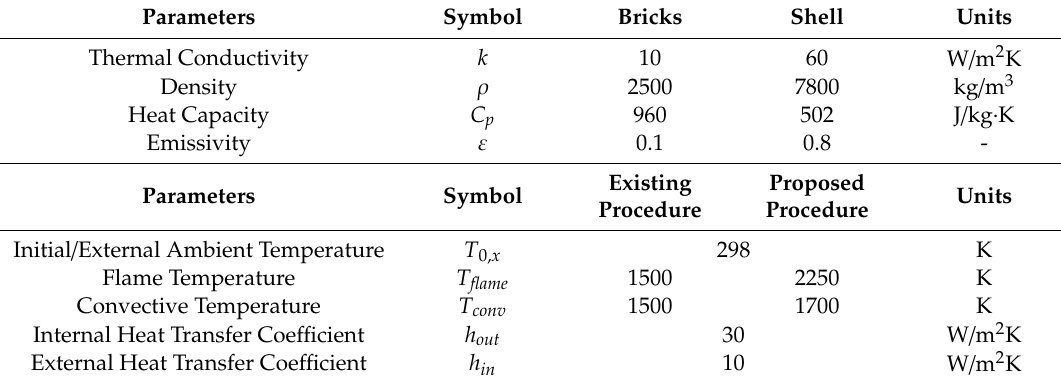
Table 2. Material properties and boundary conditions utilized in the thermal modeling study